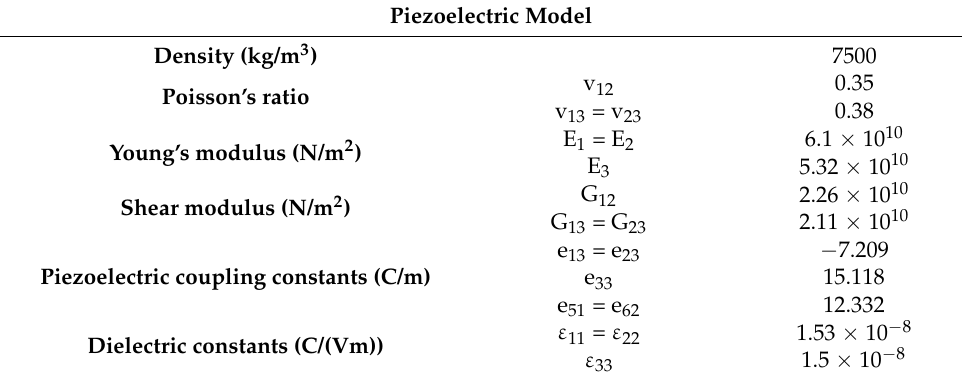
Table 2. Electro-mechanical properties of the piezoelectric